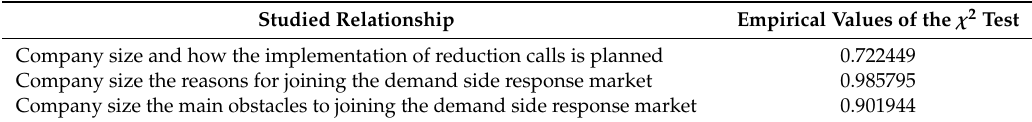
Table 5. Empirical values of the χ 2 test for the studied relationships (the size of the